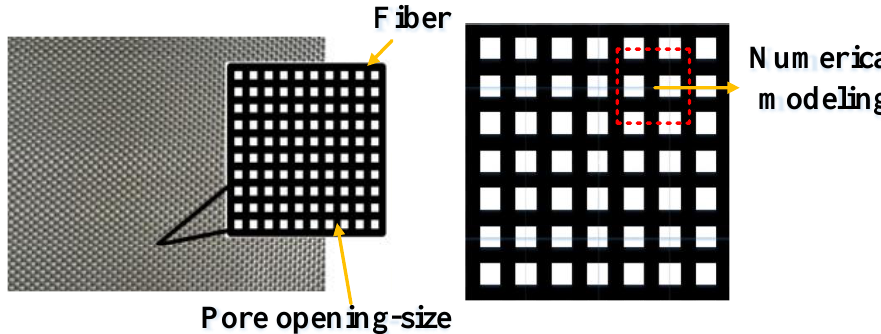
Figure 4. Structure of a PVD membrane of woven fabric.